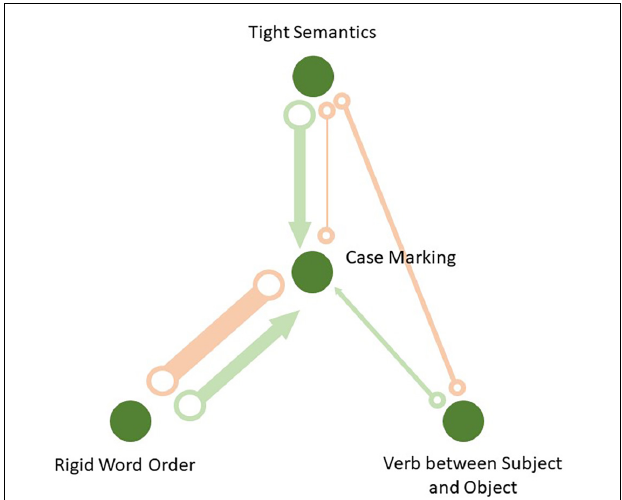
FIGURE 6 | Causal network based on the FCI algorithm: Thickness of the edges reflects their frequencies in 1,000